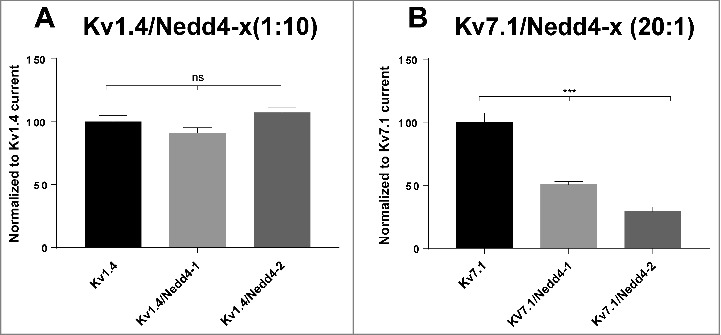
Two-electrode voltage clamp recordings of Xenopus laevis oocytes expressing Kv1.4 channels and Nedd4-x. The current levels were measured at peak amplitude at +30 mV for Kv1.4 and +60 mV for Kv7.1 and normalized to the peak current for Kv1.4 or Kv7.1 expressed alone. (A) Kv1.4 and Nedd4-1 or Nedd4-2 in a molar ratio of 1:10. Nedd4-x had no significant effect on Kv1.4 current levels when comparing oocytes co-expressing Kv1.4 and Nedd4-x to oocytes only expressing Kv1.4 (B) Kv7.1 and Nedd4-1 or Nedd4-2 in a molar ratio of 20:1. Nedd4-x had significant effects on Kv7.1 current levels when comparing oocytes co-expressing Kv7.1 and Nedd4-x to oocytes only expressing Kv7.1. Presented is a summary of three individual two-electrode voltage clamp experiments. 16 ≤ n ≤ 27 for each group. Noteworthy, no change was observed on current kinetics of either Kv1.4 or Kv7.1 following Nedd4-x co-expression (data not shown).